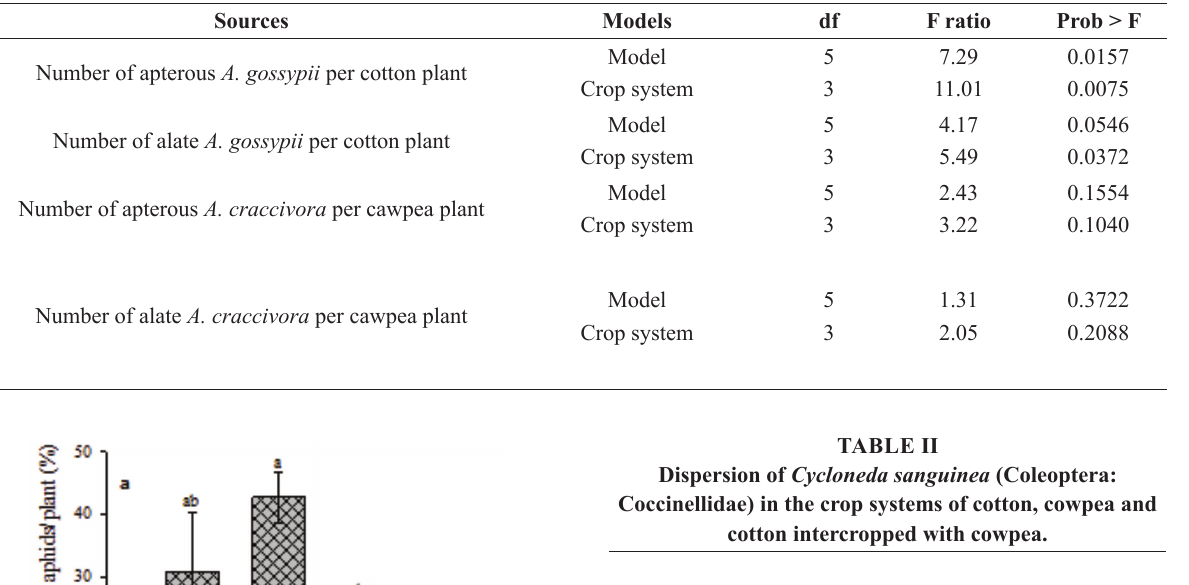
Summarized model of the one-way analyses of variance (ANOVA) for the effects of crop systems (cotton or cowpea and cotton intercropped with cowpea) on the populations of apterous and alate Aphis gossypii and Aphis craccivora (Hemiptera: Aphididae).